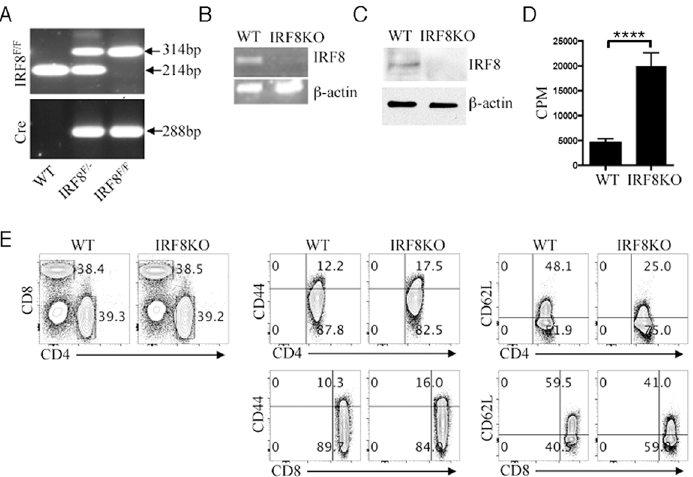
Fig 1. IRF8-deficient T cells exhibit a pre-activated phenotype and more proliferative capacity in response to antigenic stimulation. (A) IRF8 fl/fl mice were cross-bred with CD4-Cre mice to generate mice with deletion of IRF8 in the CD4 and CD8 compartments (IRF8KO) and the IRF8 fl/fl /Cre alleles were identified by PCR analysis of mouse tail genomic DNA. Presence of the 314bp band indicates Irf8 -floxed DNA, while the 214bp band is consistent with size of the endogenous Irf8 gene sequence in the wild-type mouse genome. (B, C) Na ï ve CD8 + T cells isolated from the spleen were activated with anti-CD3/CD28 for 3 days and analyzed for IRF8 expression by (B) RT-PCR or (C) western blotting. (D) The TCR-activated WT or IRF8KO CD8 + T cells were also analyzed by the thymidine incorporation assay. (E) Na ï ve T cells isolated from spleen were analyzed by FACS. Numbers in quadrants indicate percentages of T cells expressing the cell surface markers, CD44 or CD62L. Data represent at least 3 independent experiments.